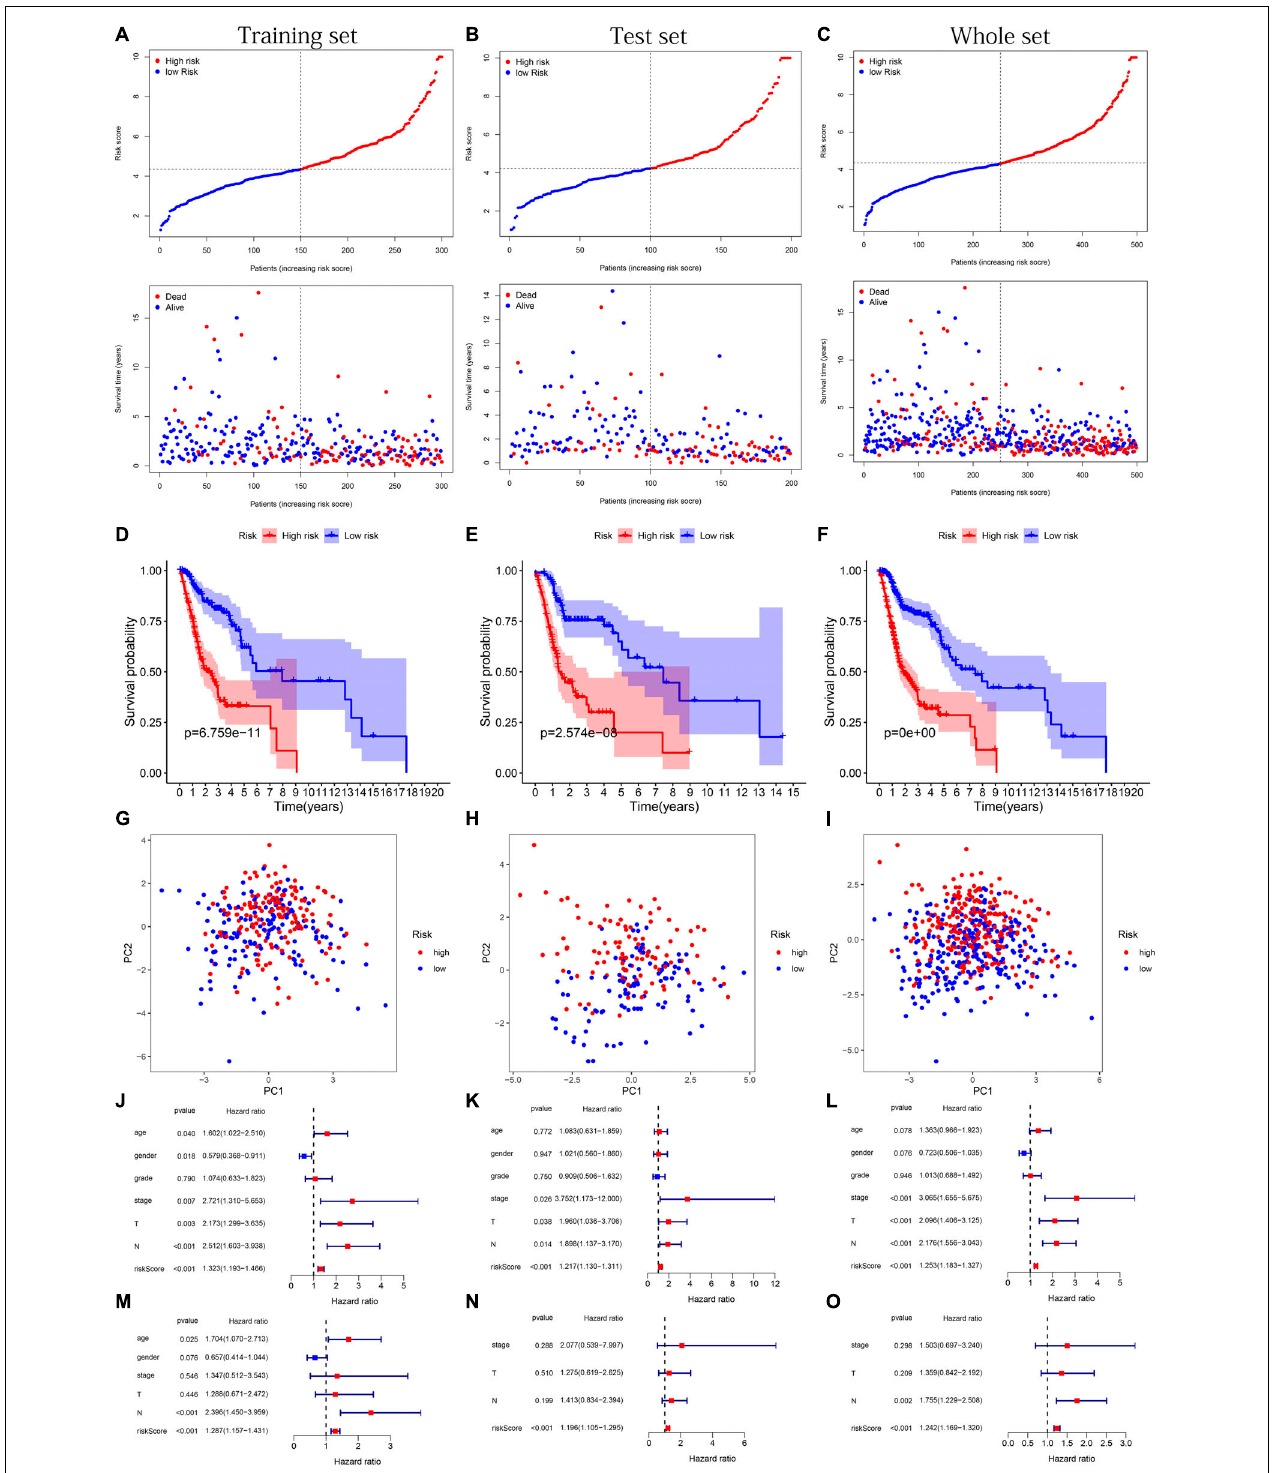
FIGURE 5 | Risk plots, survival curves, and PCA discrete trend charts based on prognostic model and forest plots based on univariate and multivariate Cox regression analysis results. (A–C) Risk plots of training, test, and whole sets, respectively. (D–F) Survival curves of training, test, and whole sets, respectively. (G–I) PCA discrete trend charts of training, test, and whole sets, respectively. (J–L) The forest plots show the results of the univariate Cox regression analysis of the training, test, and whole sets, respectively. (M–O) The forest plots show the results of the multivariate Cox regression analysis of the training, test, and whole sets,